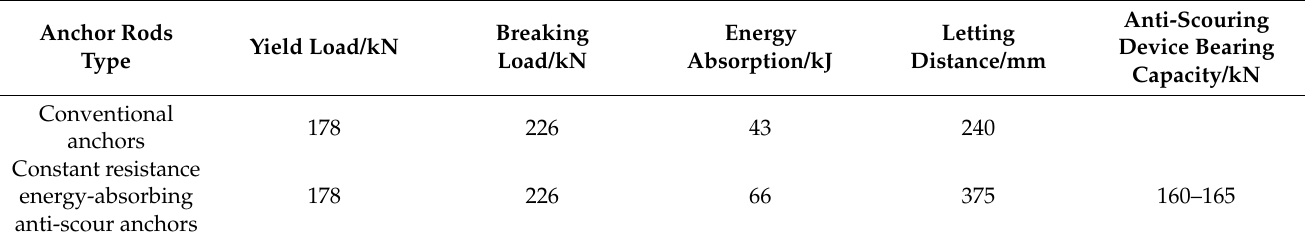
Table 1. Comparison of anchor force characteristics.